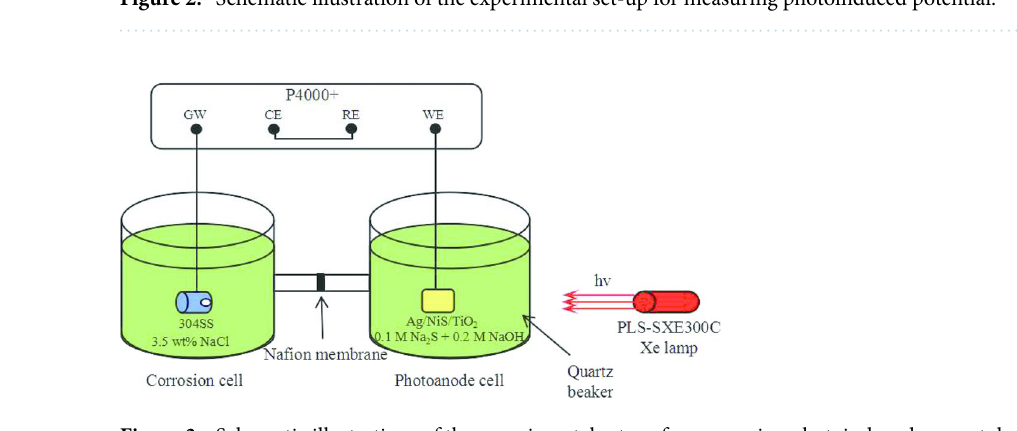
Figure 3. Schematic illustrations of the experimental set-up for measuring photoinduced current